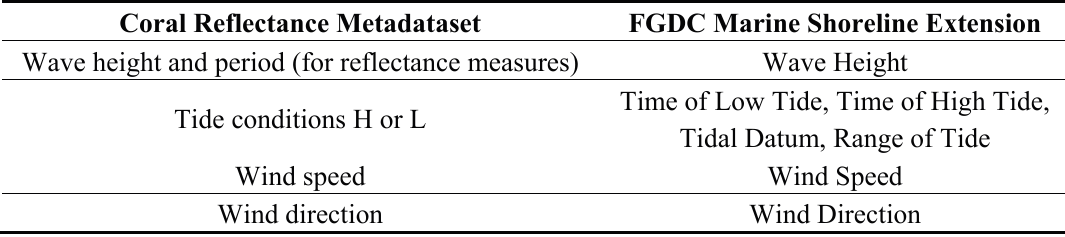
Table A12. Mappings from FGDC Content Standard for Digital Geospatial Metadata (Shoreline Metadata Profile) to the underwater benthic reflectance